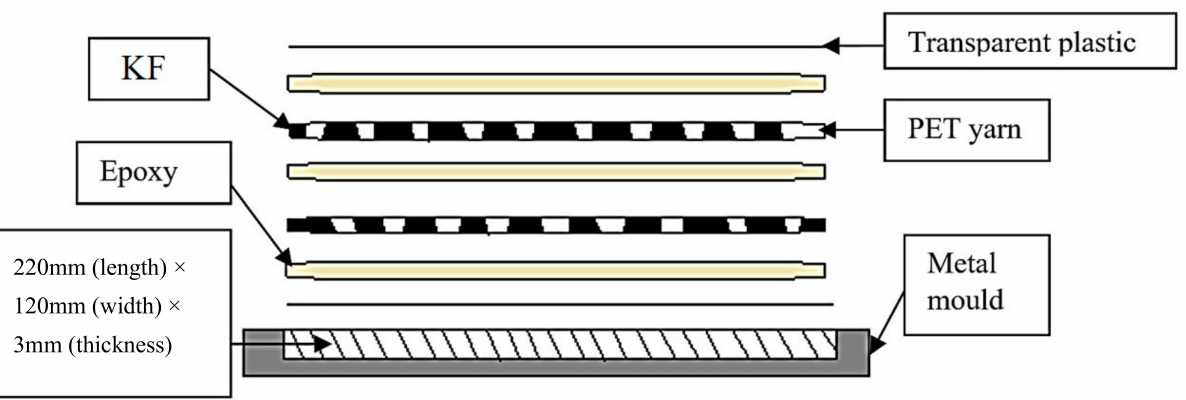
Figure 2. Arrangement of kenaf fiber and PET yarn with epoxy in the metal mold.